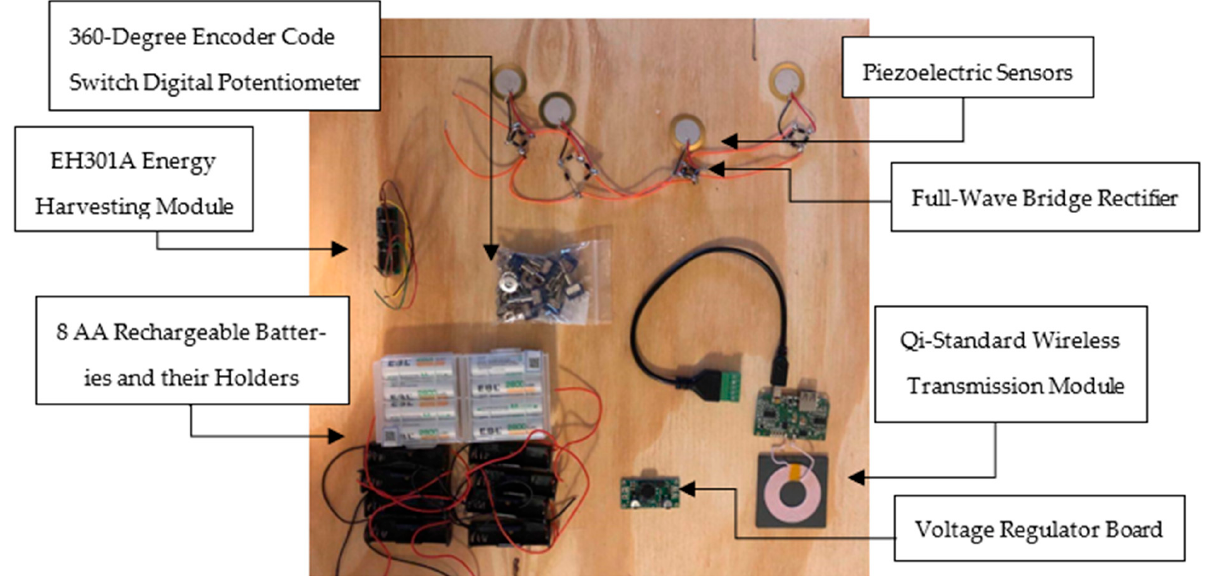
Figure 5. The System Overview and Components.